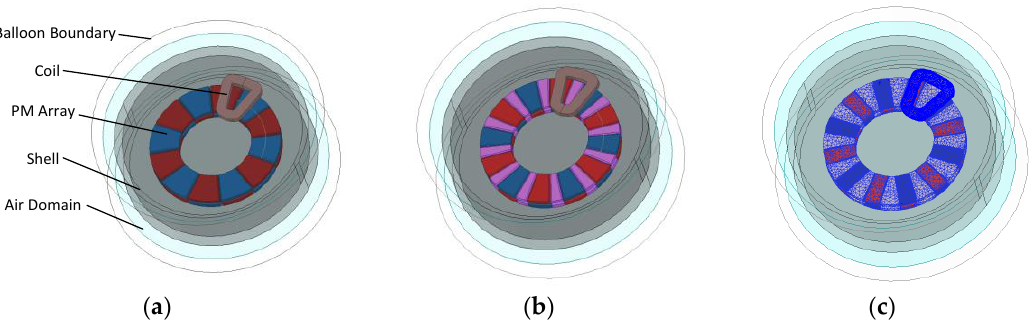
Figure 7. 3-D FEM models of different DVCMs : ( a ) Conventional magnetic pole; ( b ) Conventional Halbach array; ( c ) Variable pole-arc ratio Halbach array (with mesh plots).